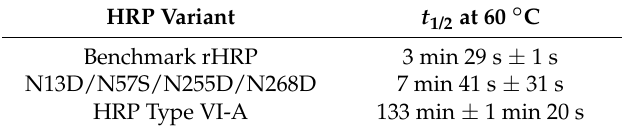
Table 6. Half-life of plant HRP, rHRP and N13D/N57S/N255D/N268D at 60 ◦ C in 50 mM KH 2 PO 4 pH